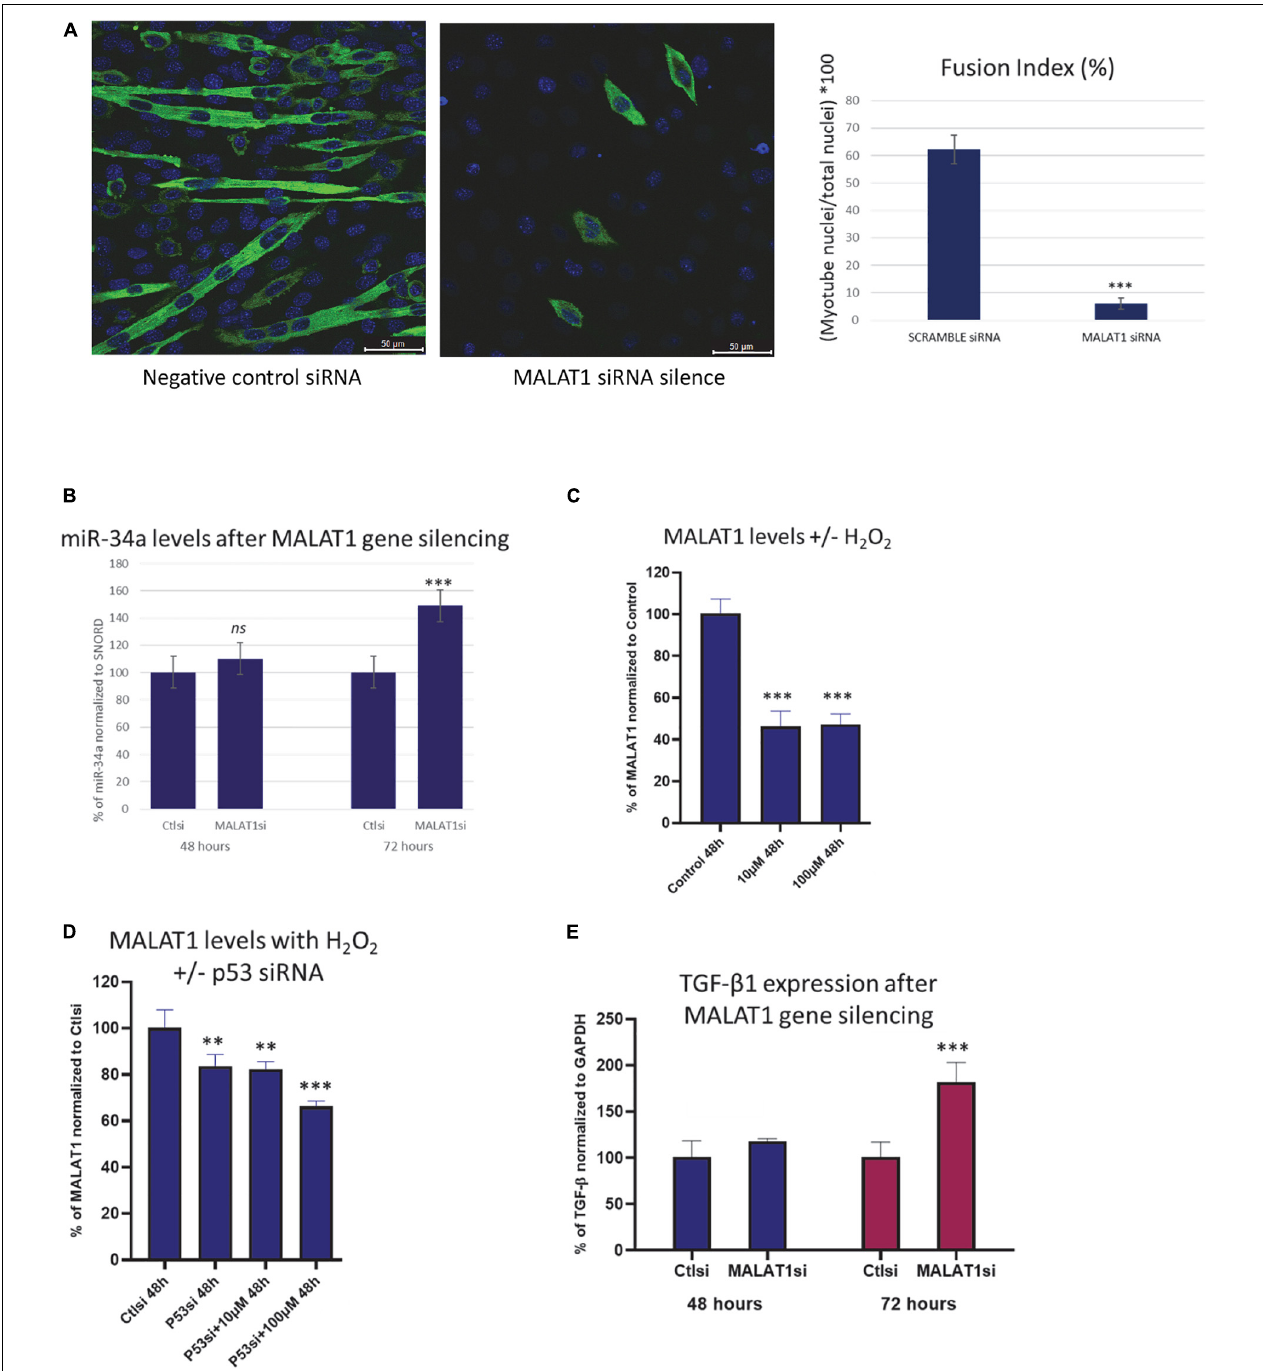
FIGURE 2 | (A) Confocal images of C2C12 cells cultured in differentiation medium transfected with scramble (control) siRNA (left) or MALAT1 siRNA (right) showing impaired differentiation with MALAT1 silencing. (B) Expression levels of miR-34a-5p in C2C12 mouse myoblasts transfected with scramble control or with MALAT1 siRNA (MALATsi). siRNA transfection is effective after 72 h, and shows increased miR-34a-5p levels with MALAT1 inhibition. (C) Decreased expression of MALAT1 in C2C12 mouse myoblasts after exposure to hydrogen peroxide (H 2 O 2 ). (D) The decrease in MALAT1 expression after hydrogen peroxide exposure is attenuated with p53 inhibition using siRNA (p53si). (E) Expression levels of TGF- β 1 in C2C12 mouse myoblasts transfected with scramble control or with MALAT1 siRNA (MALATsi). siRNA transfection is effective after 72 h, and shows increased TGF- β 1 levels with MALAT1 inhibition. ns P > 0.05, ∗∗ P < 0.01, ∗∗∗ P < 0.001. All assays were performed in